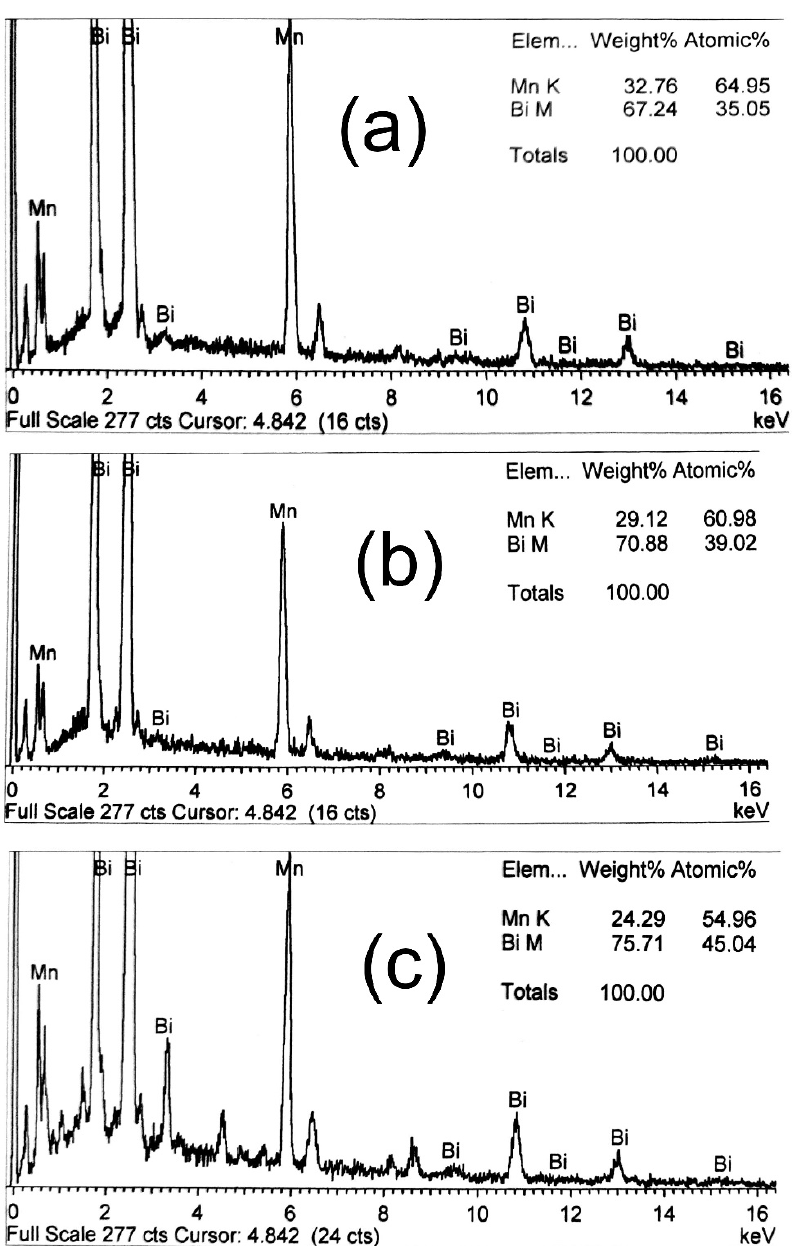
Figure 1. EDX spectra for the different MnBi samples; Sample I ( a ), Sample II ( b ) and Sample III ( c ). The different films were heat-treated around the corresponding temperatures of the formation (T form ) of the MnBi phase. Table 2 displays the annealing temperatures for the distinct samples (T ann ), around T form